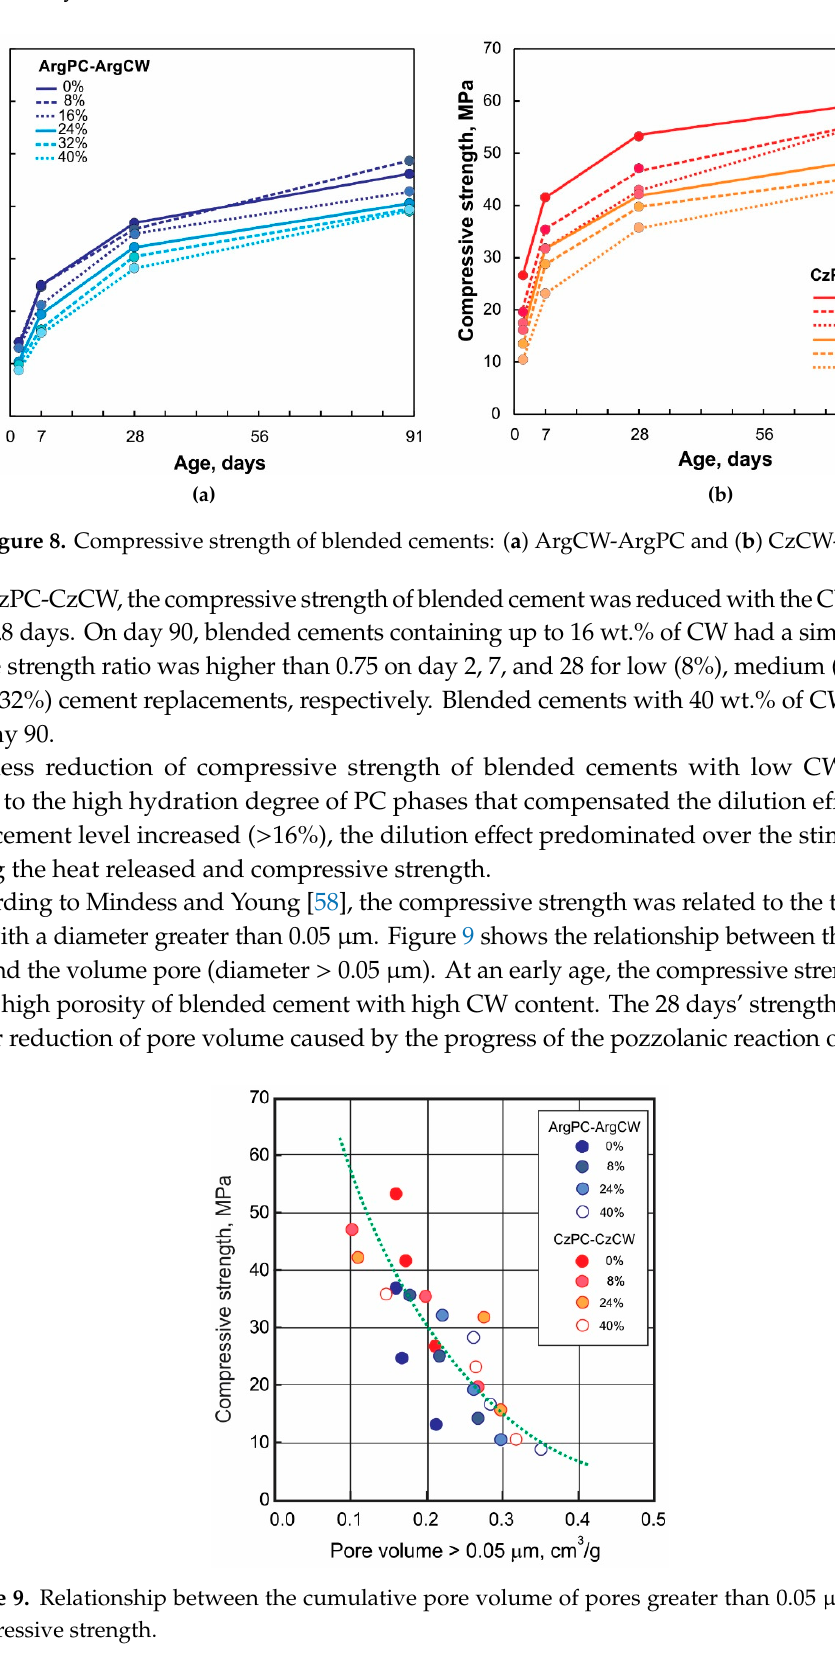
Figure 9. Relationship between the cumulative pore volume of pores greater than 0.05 µ m and the compressive